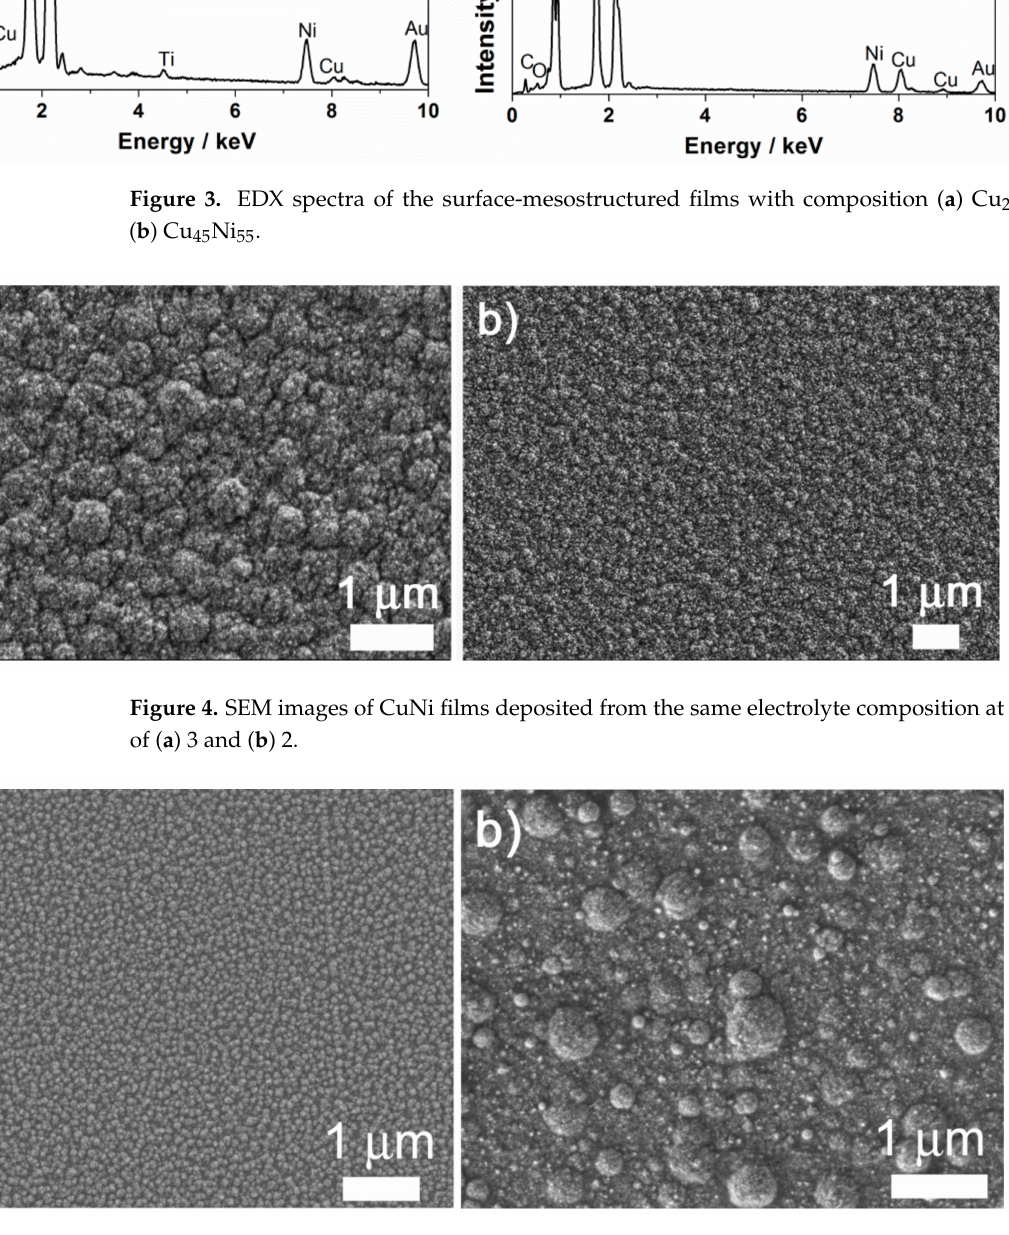
Figure 5. SEM images of films electrodeposited at j = –100 mA · cm − 2 and 150 s from ( a ) the base electrolyte and ( b ) the base electrolyte without Cu ions, at pH = 6.25. Note that the SEM image of ( a ) corresponds to a lower-magnified image of the deposit shown in Figure